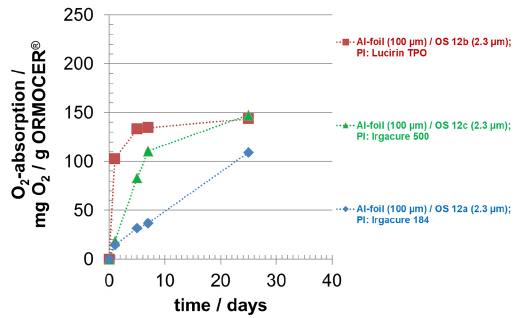
Figure 4. Oxygen absorption of oxygen scavenger (OS) ‘ORMOCER ® OS12’ with different photo- initiators (PI); curing time: 0.5 min; OS coating thickness (dry) around 2.3 µm.